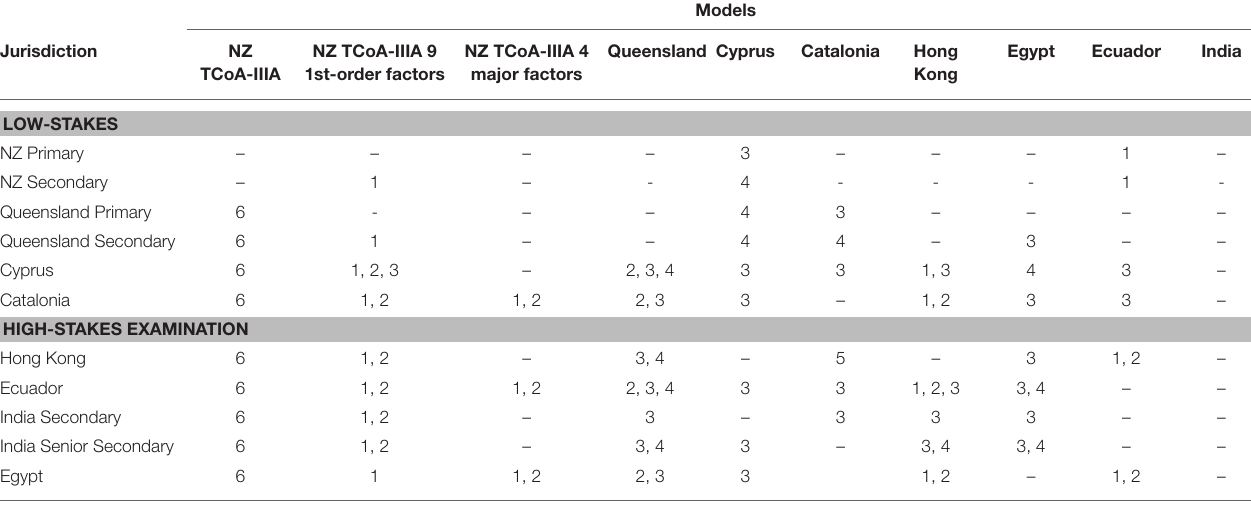
TABLE 3 | Model status by teacher